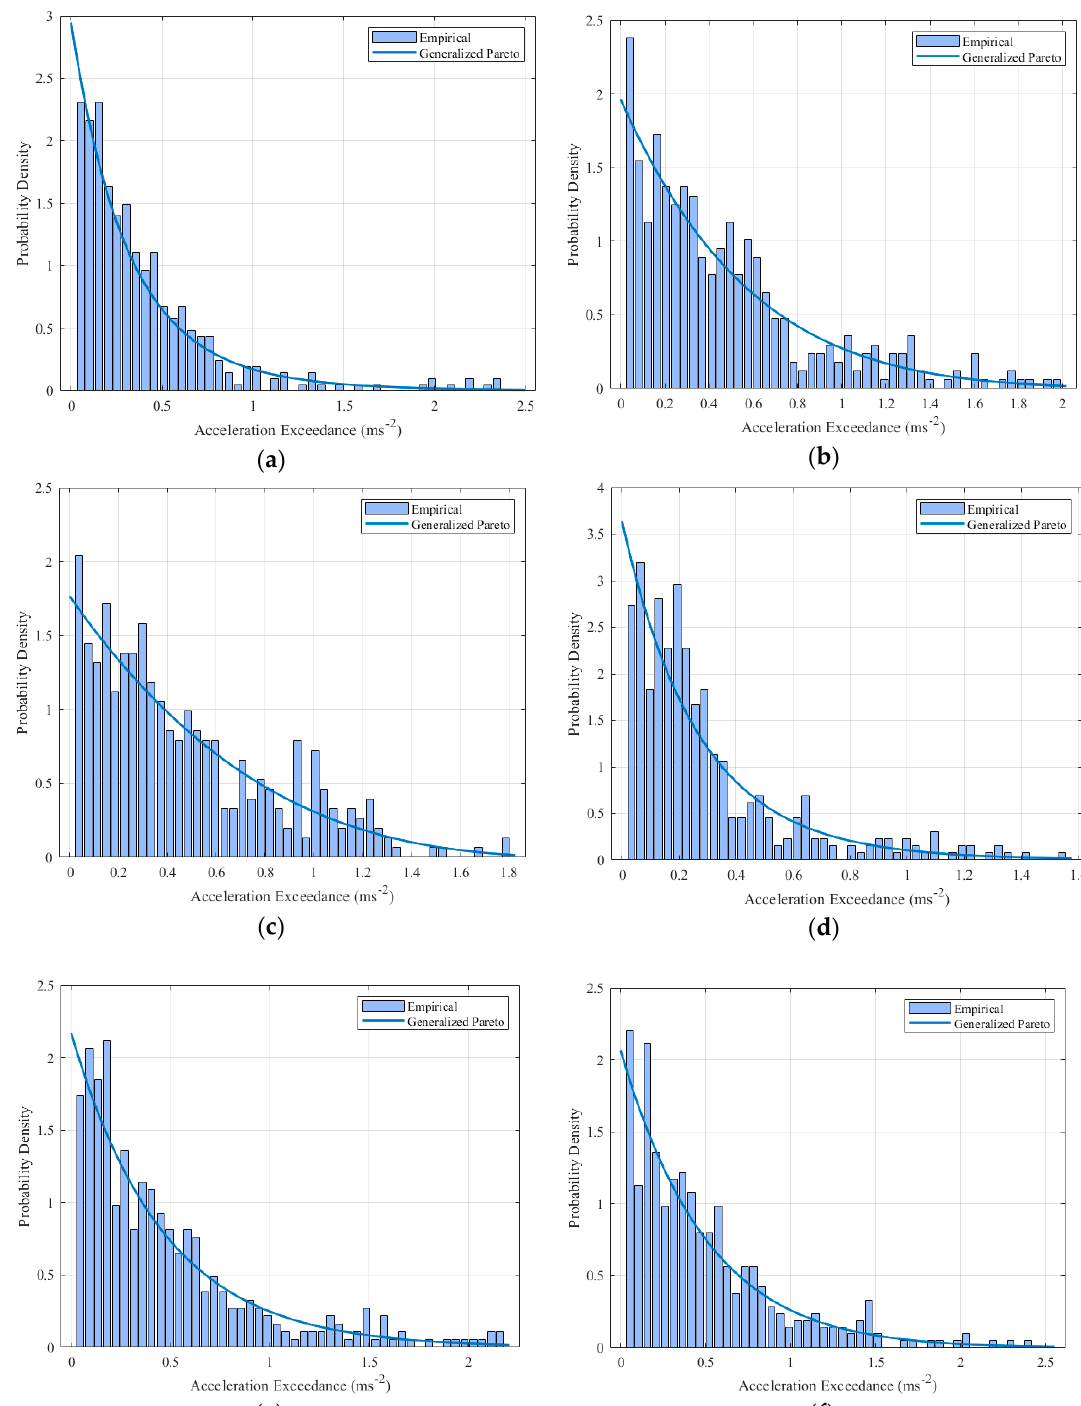
Figure 16. Generalised Pareto probability density function (PDF) fits to acceleration exceedance data from Bret 7 wave tests, for ( a ) Phase A; ( b ) Phase B; ( c ) Phase C; ( d ) Phase D; ( e ) Phase E and ( f ) Phase F.